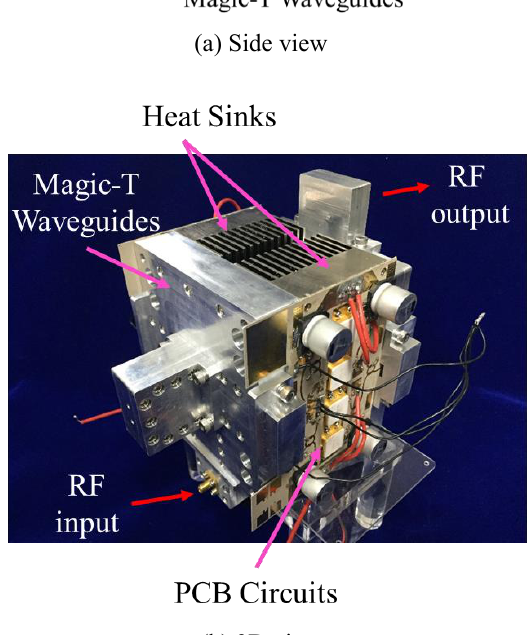
Figure 11: Waveguide-to-microstrip transitions with the back-to-back 4-to-1 power combiner.